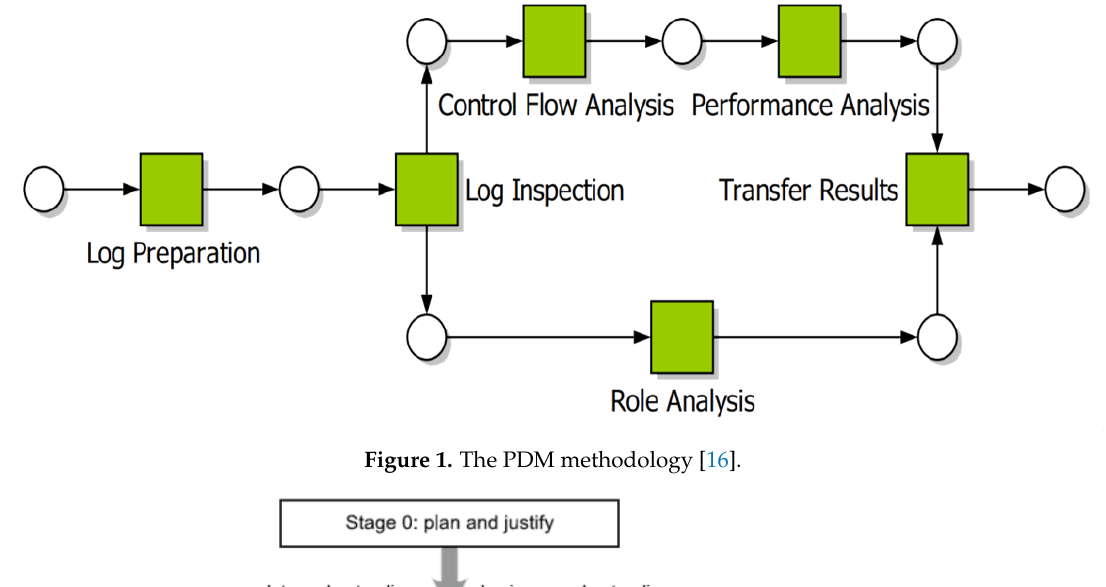
Figure 1. The PDM methodology [16].